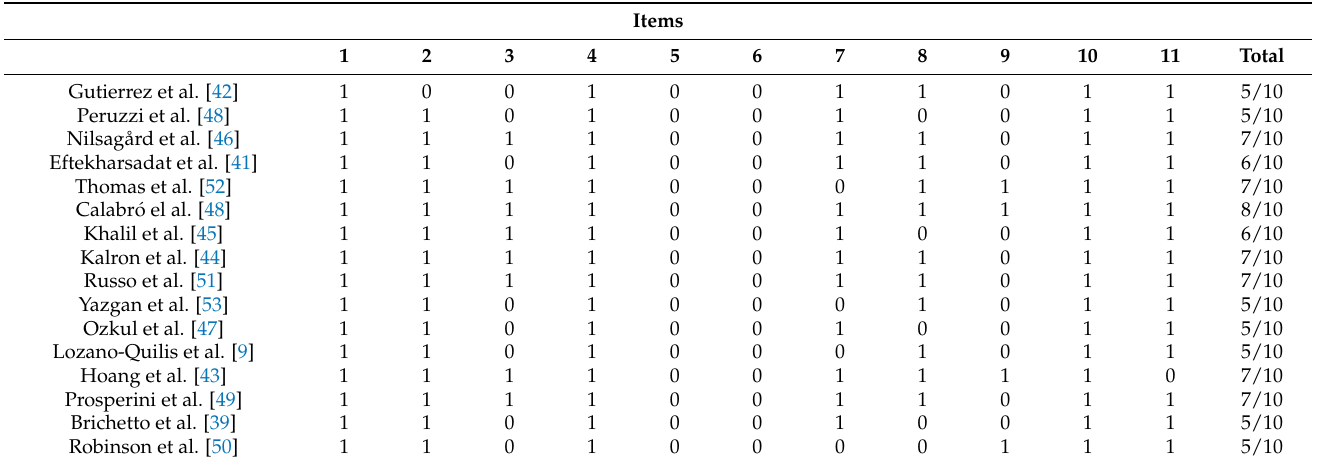
Figure 2. Risk of bias summary. Review authors’ judgements about each risk of bias item for each included study (Risk of Bias scale) and risk of bias graph. Review authors’ judgements about each risk of bias item presented as percentages across all included studies (Risk of Bias scale) [9,39–53]. Table 2. PEDro scores for each study.